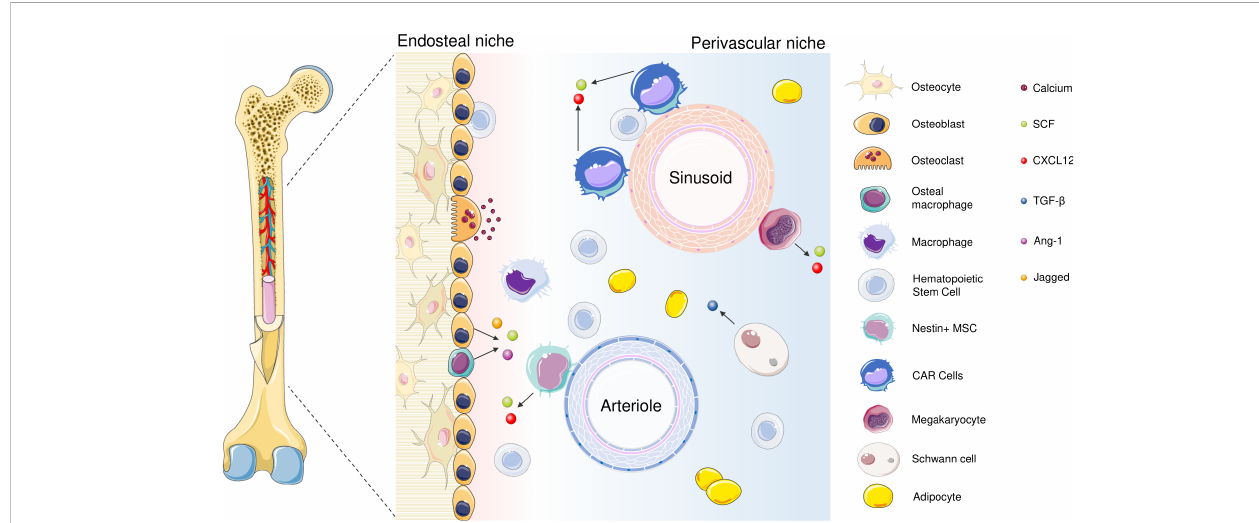
FIGURE 1 The cellular components of the BM niches include endothelial cells, HSCs, megakaryocytes, osteoblasts, osteoclasts, adipocytes, sympathetic neurons that are related to Schwann ’ s cells, bone macrophages and reticular cells (90, 92). Both soluble factors and direct contact between cells regulate HSC maintenance. Quiescent HSCs are kept in contact with osteoblasts and Nestin+ MSCs as well as CXCL12 - abundant reticular (CAR) cells in the perivascular niche; both secrete soluble factors such as Stem Cell Factor (SCF), CXCL12 (CXC motif chemokine ligand 12) and Ang-1 (Angiopoietin-1) while in the perivascular niche, secrete (93). Osteomacs, the bone-marrow-resident macrophages are also found in the endosteal niche and facilitate colonization; in the absence of osteomacs, HSCs are shown to leave BM and join circulation (92, 94). Jagged-1 is released from cells of osteocyte lineage, and responsible for the activation of Notch pathway (95). Organized as a monolayer in the internal compartment of blood vessels, ECs take part in various physiological processes including facilitating blood fl ow, contributing coagulation, nutrient exchange and regulate hematopoiesis (96). According to their localization in the BM, they are divided into two categories: sinusoid endothelial cells (SECs) which have low CD31 and Endomucin expression (type L), or arteriolar endothelial cells (AECs) with CD31 and Endomucin expression (type H). Both cell types play different roles in the modulation of BM niche (97). SECs are the compartments of more permeable sinusoidal vessels and secrete high levels of CXCL12 as well as E-selectin that regulate HSC homing (96, 98). On the contrary, AECs are the compartments of arteriolar vessels which have low penetration and ensure a relatively hypoxic environment (99, 100). AECs generate SCF which play a fundamental role in maintaining HSCs and express CXCL12. In addition, they produce Netrin-1 that retains HSCs ’ quiescence and self-renewal (101). Megakaryocytes are the basic subunit in the perisinusoidal area and regulate HSC quiescence (102 – 104). In the endosteal niche, osteoblasts stabilize bone formation and produce mediators which are essential for HSC maintenance; and CXCL12, granulocyte colony-stimulating factor (G-CSF), SCF, Annexin 2 (ANXA2), Ang-1, Thrombopoietin (TPO) that are required for the regulation of HSC homing, quiescence and mobilization (105 – 113). Schwann cells are found in the perivascular niche and protect the quiescent HSCs through transforming growth factor- b (TGF- b ) (114). Bone marrow adipocytes were also reported to support HSC proliferation through secreting adiponectin and contribute to energy metabolism (115,